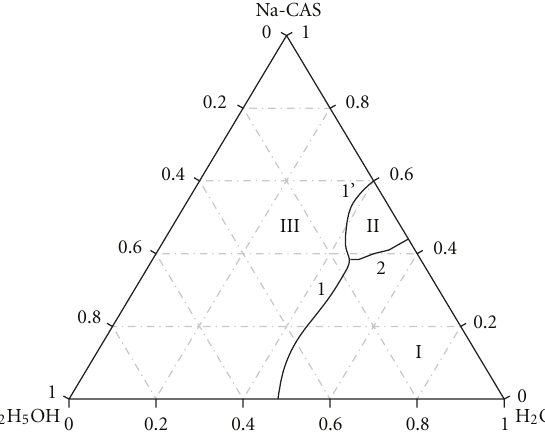
Figure 10: Solubility diagram of Na-CAS in water/ethanol at 18 ◦ C.